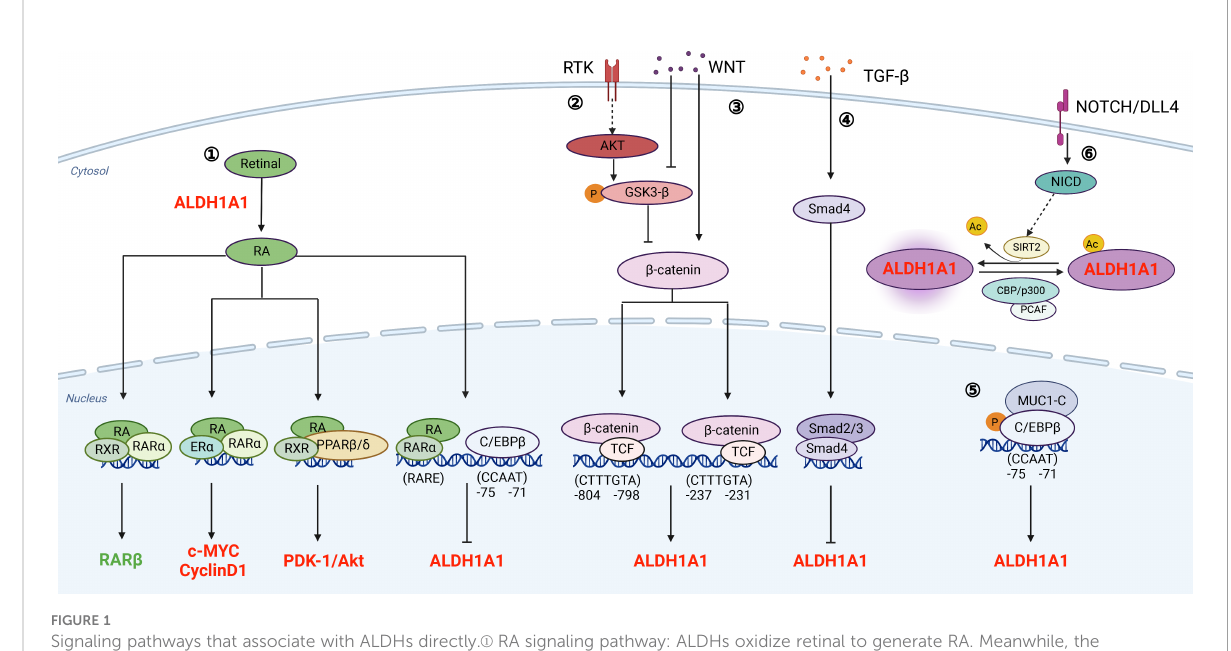
FIGURE 1 Signaling pathways that associate with ALDHs directly. ① RA signaling pathway: ALDHs oxidize retinal to generate RA. Meanwhile, the transcription of ALDH is also regulated by RA. As a feedback loop, increased levels of ALDH promote the synthesis of RA; ② and ③ PI3K/AKT pathway and WNT signaling pathway regulate the transcription of ALDH through b -catenin; ④ TGF- b signaling pathway: TGF- b inhibits the transcription of ALDH through Smad4; ⑤ MUCI-C pathway: The protein complex of MUC1-C and C/EBP b binds to the promoter of ALDH and promotes its transcription; ⑥ NOTCH/DLL4 pathway: Notch signaling promotes ALDH activity by inducing SIRT2 and triggering ALDH1A1 deacetylation. The regulators in red refer to those promoting PCSCs, and the regulators in green refer to those inhibiting PCSCs. This fi gure is generated by BioRender with an agreement number of